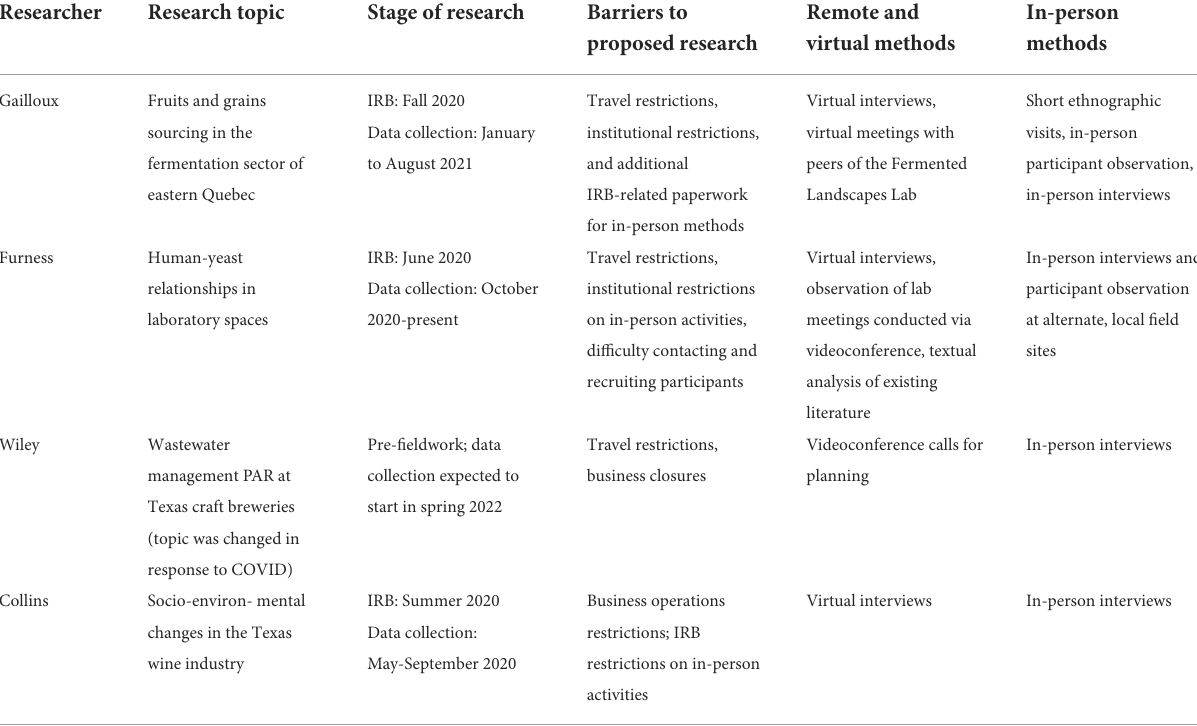
TABLE 1 Summary of research projects presented in this paper with barriers to proposed research and modifications adopted by each